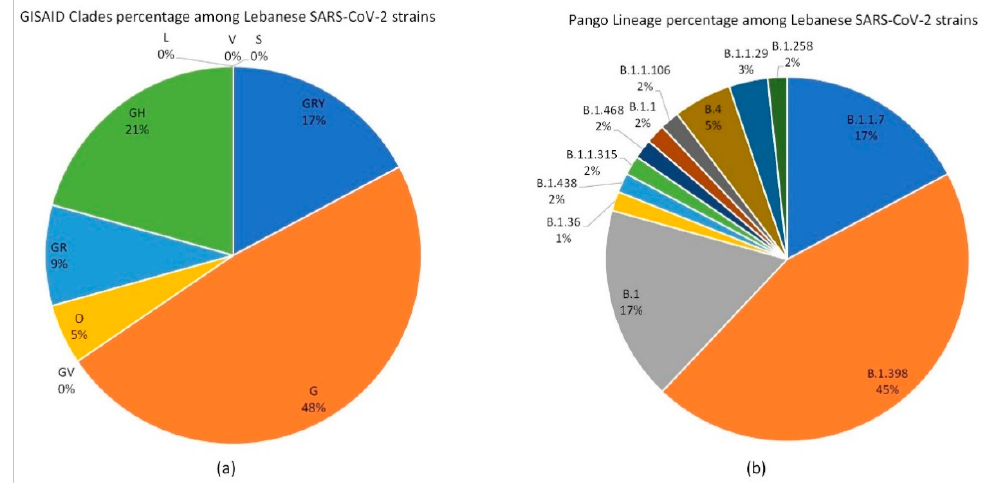
Figure 1. Percentage pie chart distribution of ( A ) GISAID clades and ( B ) Pango lineages among the 58 analyzed Lebanese SARS-CoV-2 strains. Each ( A ) clade or ( B ) lineage, as well as the percentages, are shown either on or just outside the corresponding section.